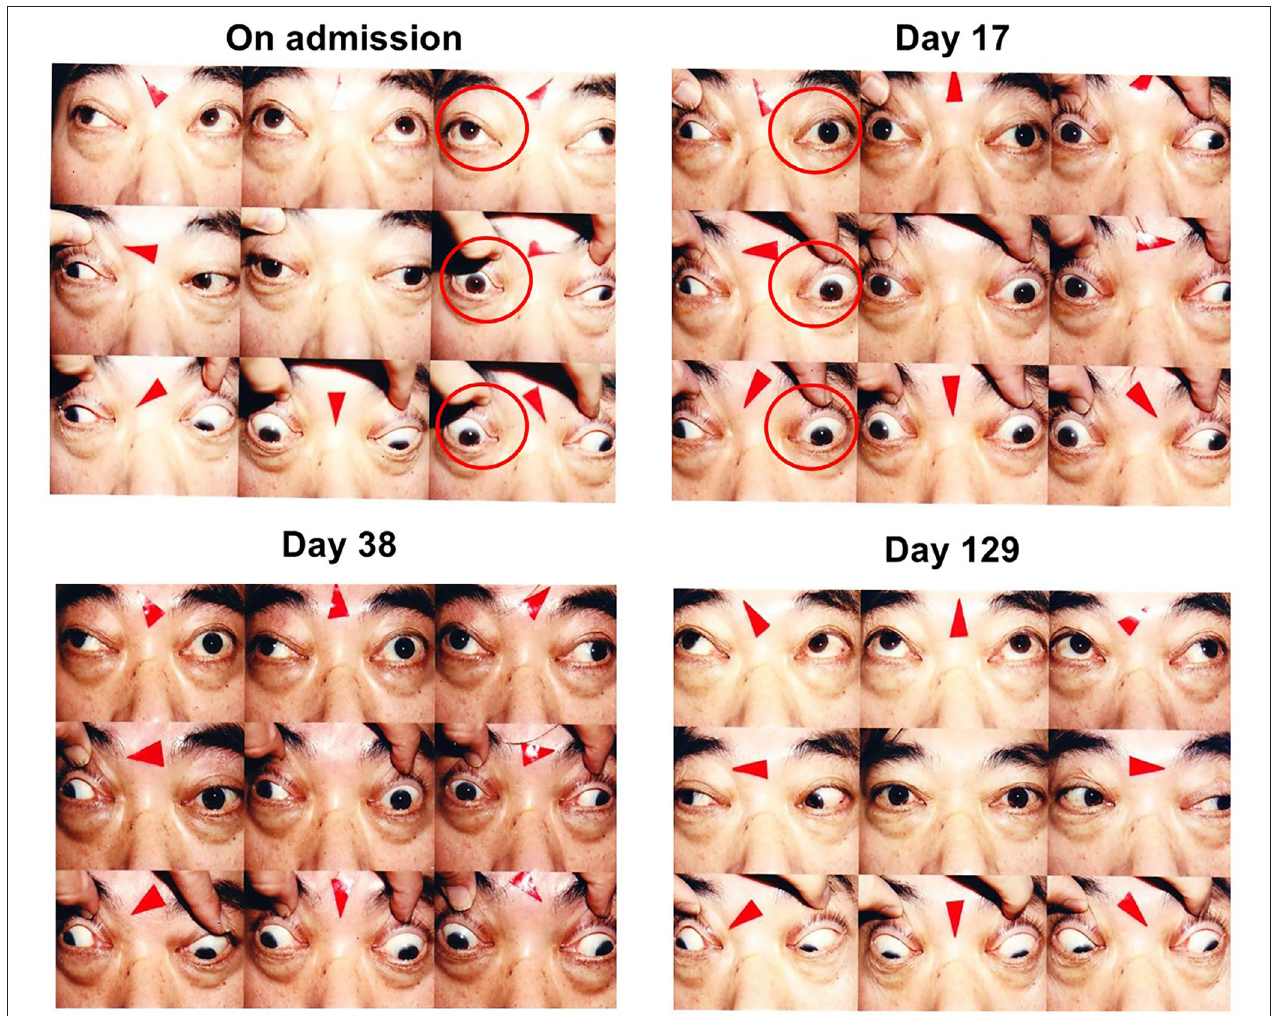
FIGURE 1 | On admission, slight ptosis was observed, and adduction failure of the right eye was observed ( left , upper panels; red circles). On day 17, adduction failure of the left eye was observed in addition to that of the right eye. Vertical movement was also impaired in both eyes. Slight ptosis was observed in both eyes, and the right eye was completely close ( right , upper panels; red circles). On day 38 after steroid therapy, ptosis and vertical movements in both eyes were recovered but horizontal movements of both eyes were not altered ( left , lower panels). On day 129, ptosis and vertical movements in both eyes were completely normalized and horizontal movements of both eyes were almost completely recovered ( right , lower